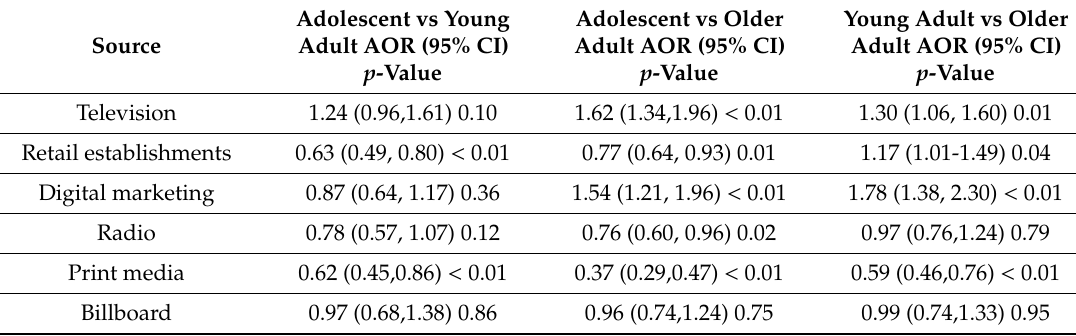
Table 2. Adjusted odds ratios (AOR) for advertising channel exposure by age